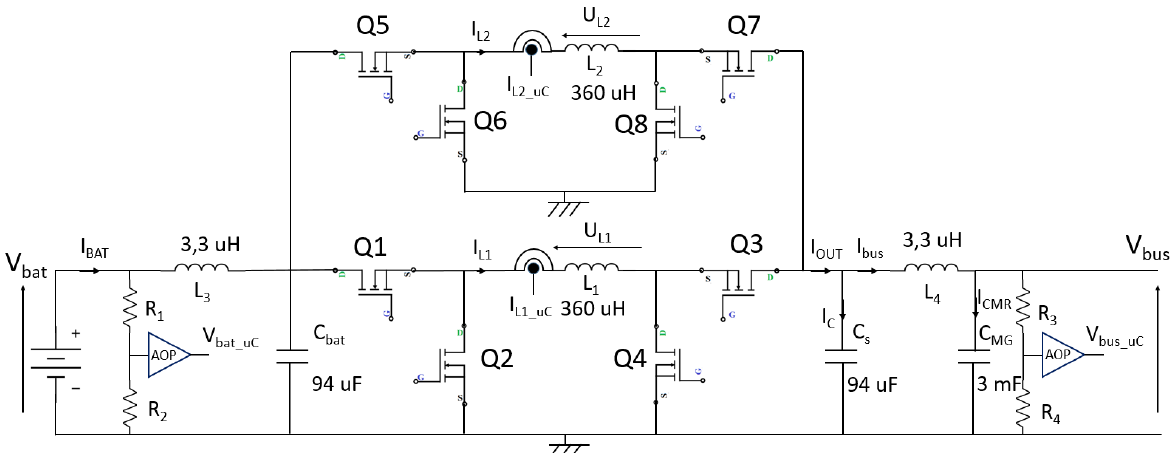
Figure 20. Schematic of the bidirectional converter.